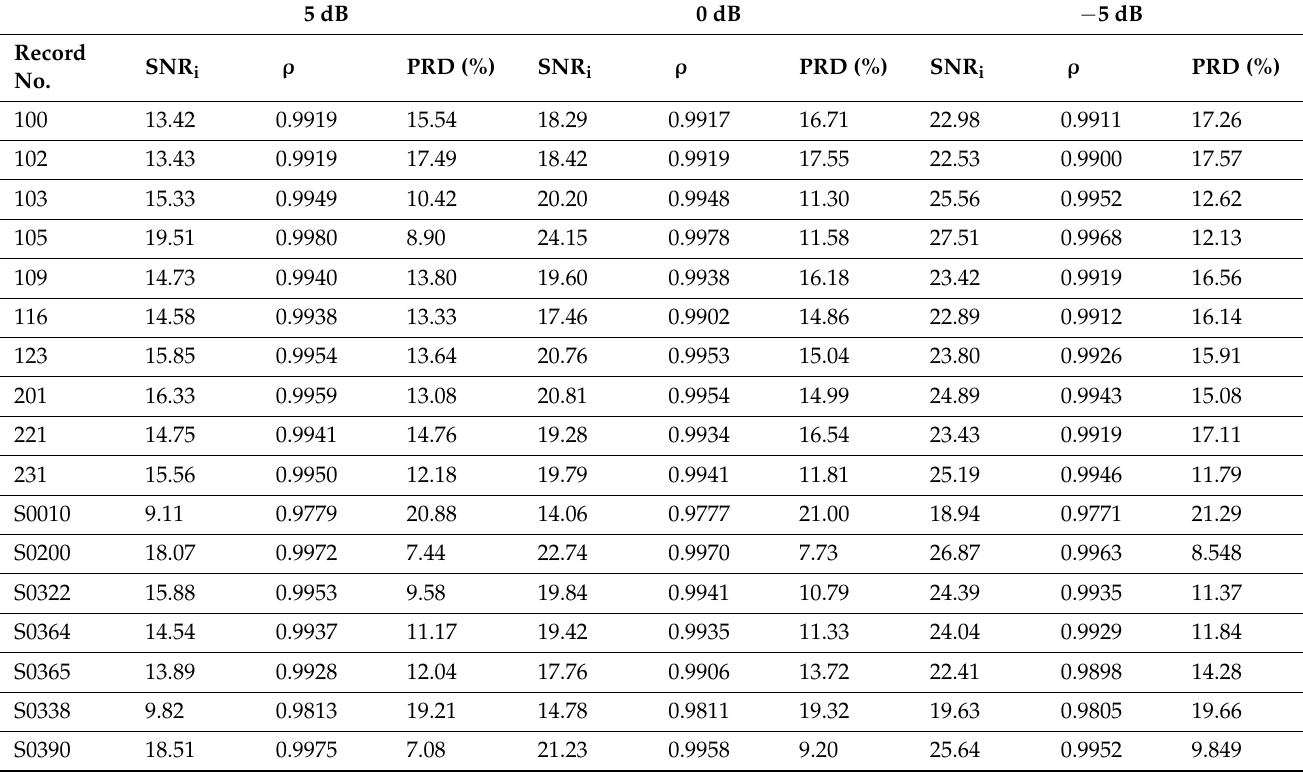
Table 5. Improvement in SNR, cross-correlation and PRD values between the denoised signal and the clean input signal in presence of 60 Hz PLI at various input SNR